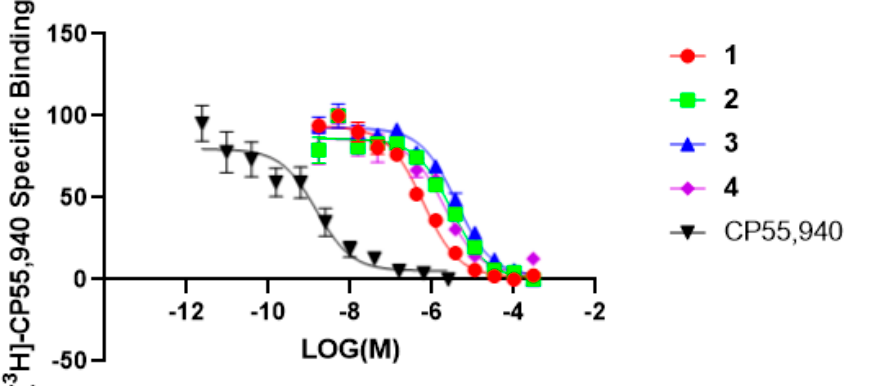
Figure 3. The radioligand displacement curves were obtained for compounds ( 1 – 4 ) for the CB2R. CP55,940 was used as a positive control.